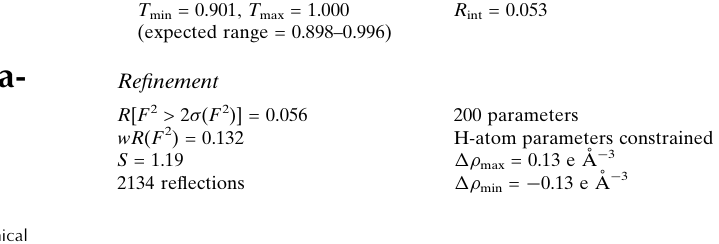
Table 1 D —H (cid:1)(cid:1)(cid:1) (cid:2) -ring interactions calculated by PLATON (Spek, 2003). Cg 1 and Cg 2 are the centroids of the phenyl rings C15–C20 and C8–C13,